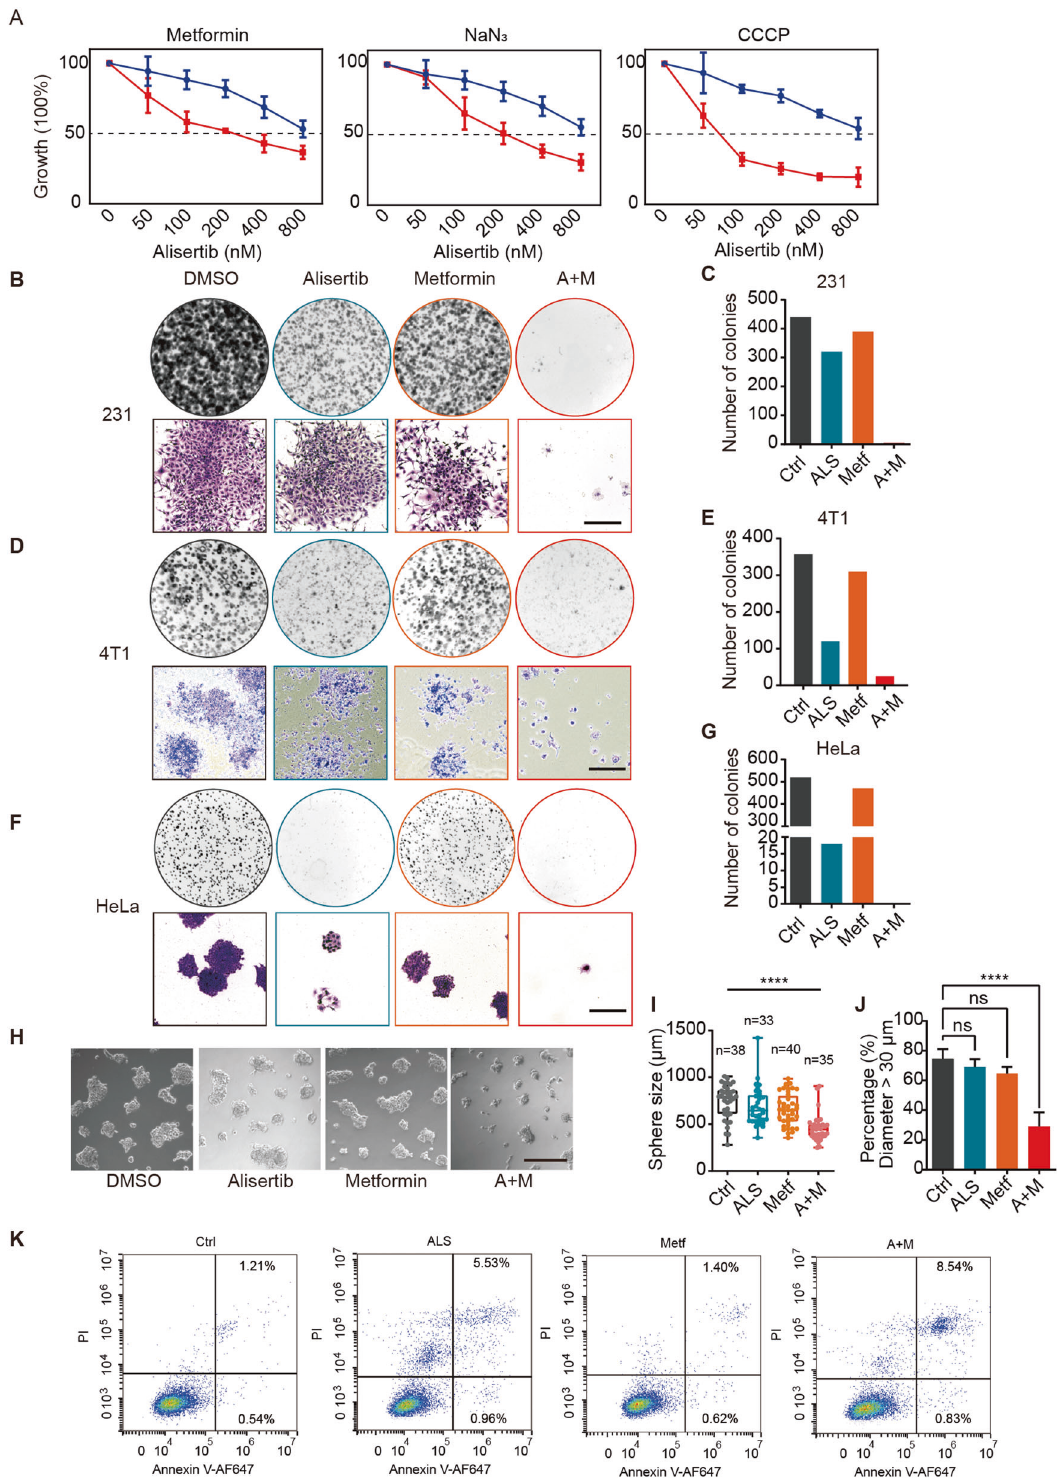
Fig. 4 OXPHOS inhibitors potentiate the anticancer ef fi cacy of alisertib. A Growth inhibition assay in MDA-MB-231 cells treated with alisertib alone (blue lines) or in combination (red lines) with mitochondrial inhibitors, including metformin (5 mM), sodium azide (1 mM), oligomycin (1 nM), or FCCP (10 mM). The relative absorbance was normalized and vehicle-treated cells were set as 100%. B – G Colony-forming assay in the MDA-MB-231 ( B ), 4T1 ( D ), HeLa ( F ) cells treated with 100 nM alisertib, 5 mM metformin, or combination (A + M). Scale bar, 500 μ m. H MDA-MB-231 cells in 3D culture. Cells were grown in Matrigel with 100 nM alisertib, 5 mM metformin, or combination treatment. Images were taken on day 5. Scale bar, 500 µm. I , J Quanti fi cation of the diameters of cell clusters ( I ) and the percentage of cell clusters in diameter exceeded 30 μ m ( J ), n = 3. ns not signi fi cant; **** p < 0.0001. One-way ANOVA. K Annexin V staining for apoptotic cells was performed in MDA- MB-231 cells after 24 h of treatment with 100 nM alisertib (ALS), 5 mM metformin (Metf), or in combination. Viable cells are in the lower left quadrant, and early apoptotic and late apoptotic cells are in the lower right and upper right quadrants, respectively. Cell Death and Disease (2021)